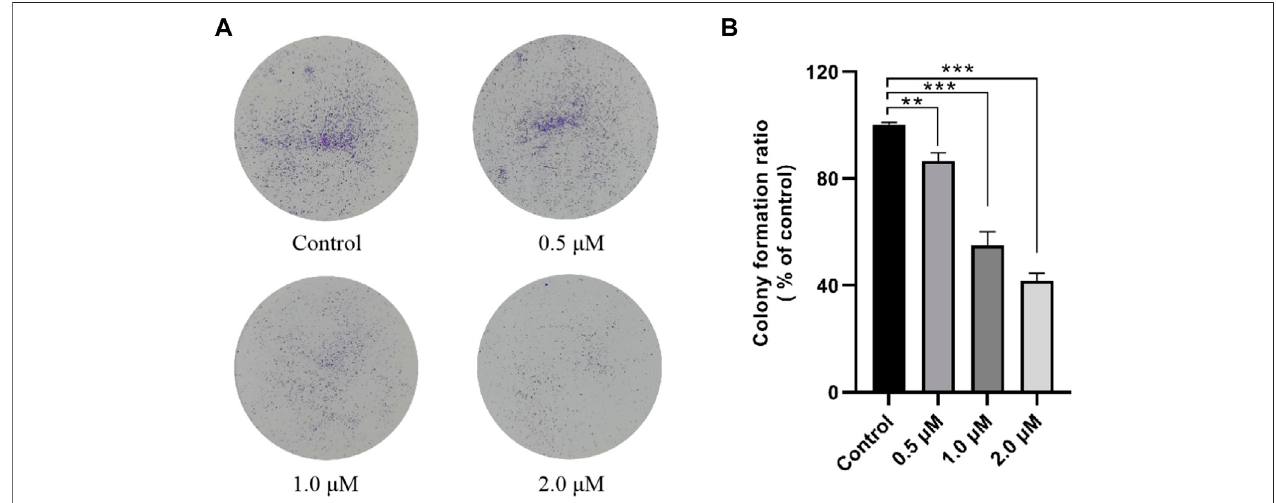
FIGURE 2 | Fluorescence microscopy images of MDA-MB-231 cells with Hoechst staining: the control group and treatment group with 1.0 μ M TMPH 12 – 9 .